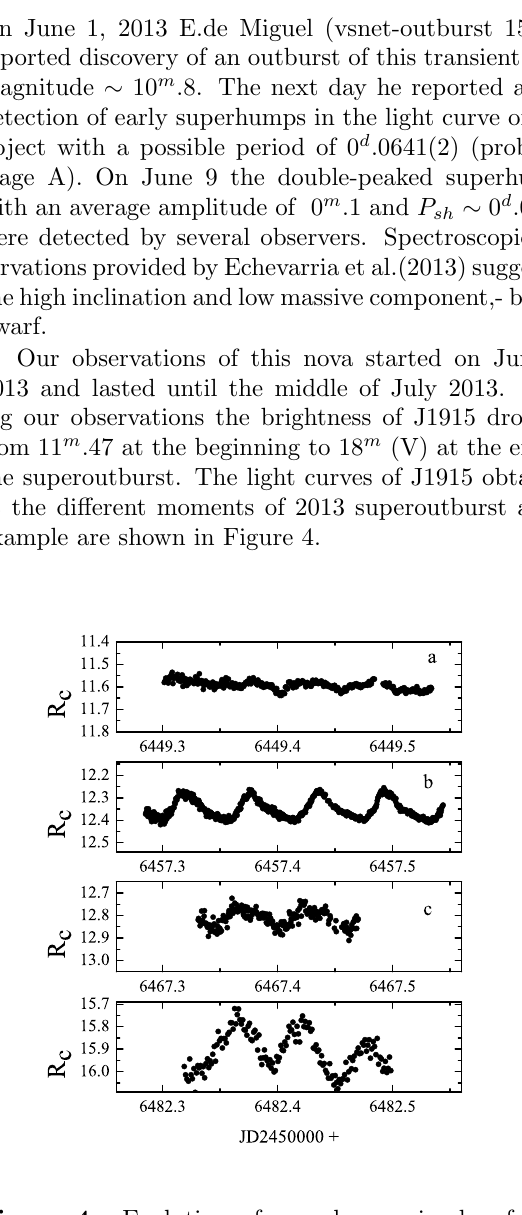
Figure 4: Evolution of superhumps in dwarf nova J1915: a - beginning of stage A superhumps; b - stage B superhumps; c - transition from B to C stage; d - post-fading stage superhumps. Scale is the same for all panels.